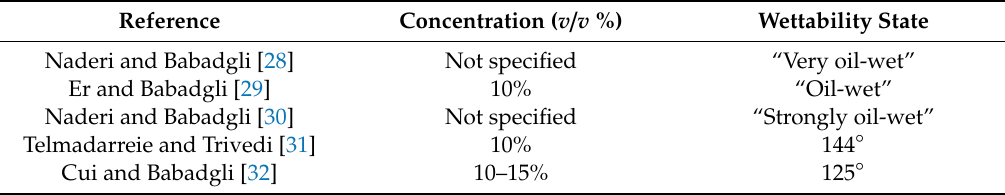
Figure 2. Schematic diagram of the microfluidic setup. Table 3. Usage of Surfasil in the literature to alter